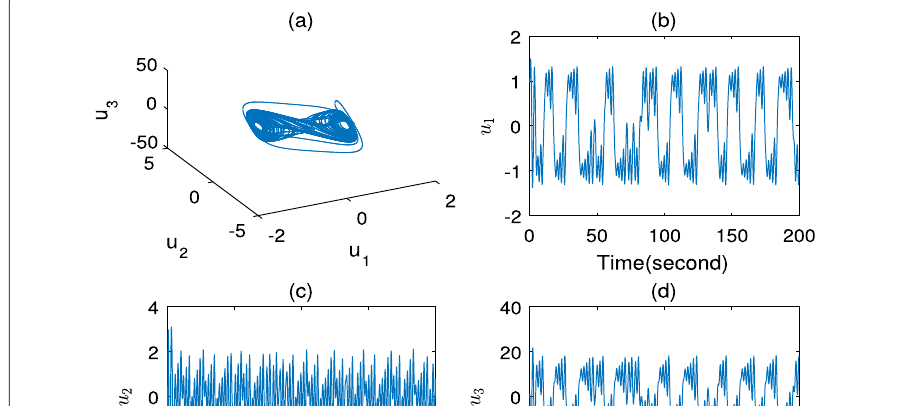
R d = R e = R g = R k = R l = R q = 10 k Ω , R h = R m = R n = 250 k Ω C 1 = C 2 = C 3 = 1 μ